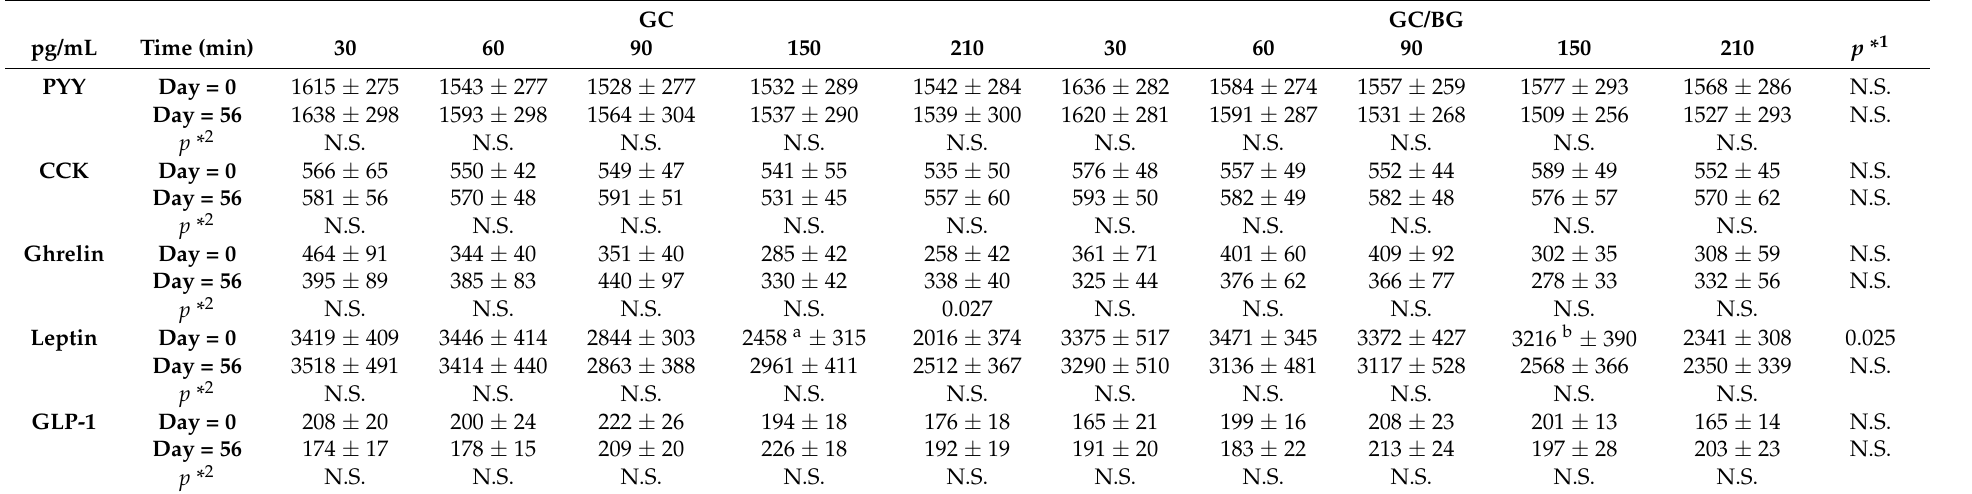
Table 3. Effects of the consumption of GC or GC/BG nutraceuticals on satiety-related hormones.